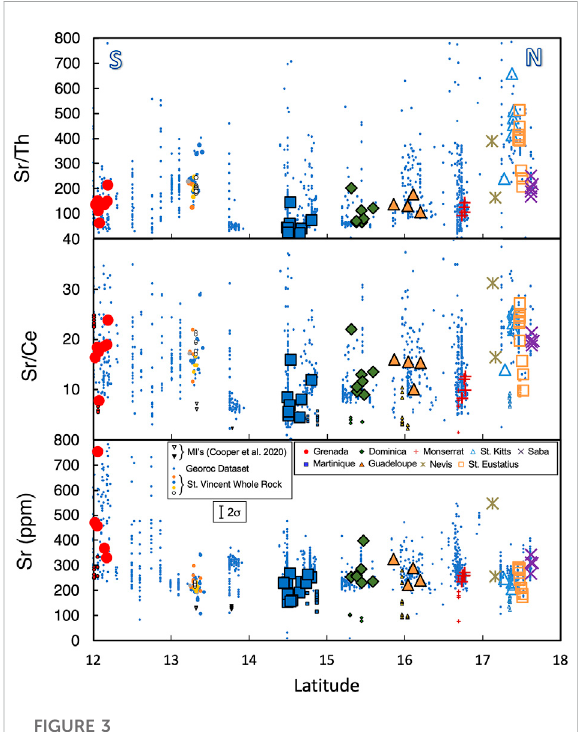
FIGURE 3 Along arc variation of Sr, Sr/Ce and Sr/Th for LAVA samples studied. Sr concentrations are elevated in Grenada while both Sr/ Ce and Sr/Th are signi fi cantly higher in samples north of Montserrat. Higher Sr/Ce is expected to be correlated with high 87 Sr/ 86 Sr(HawkesworthandPowell1980),whichiftrue,would make our data contradictory to previous fi ndings (Hawkesworth and Powell 1980; Davidson 1987; DuFrane 2009). Error for Sr variation is shown, and the reader is referred to Supplementary Table SB through D for all analytical uncertainties. Data for St. Vincent (various colored closed and open circles at ~13.3 o N Latitude) are from Lewis 1973, Bardintzeff 1992 and Heath et al., 1998; Melt inclusion data for each island from Cooper et al. (2020) are shown as small versions of the same symbol shapes and colors except as otherwise noted. Small blue dots represent data previously published, extracted fromaprecompiledexpertdataset downloaded fromhttps://georoc.mpch-mainz.gwdg.de//georoc/ with references